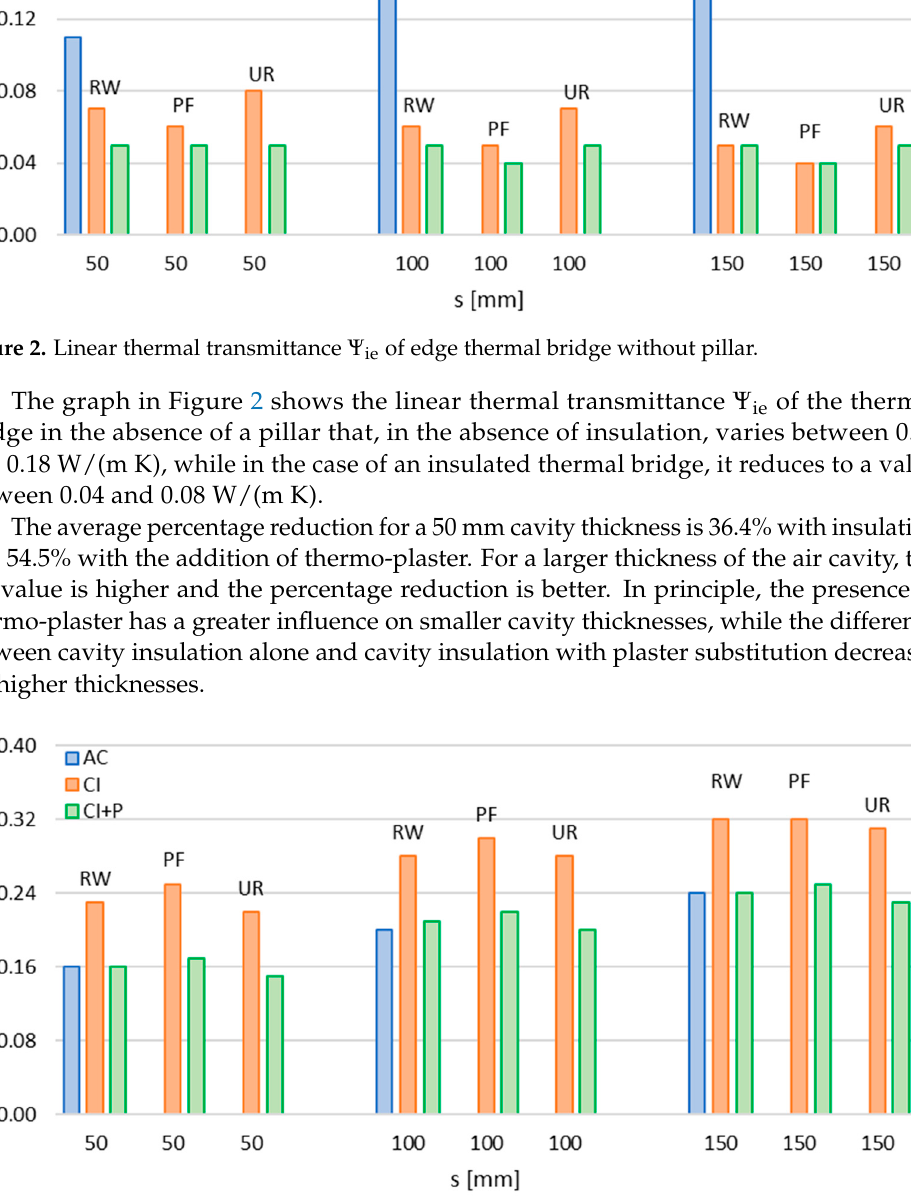
Figure 2. Linear thermal transmittance Ψ ie of edge thermal bridge without pillar.